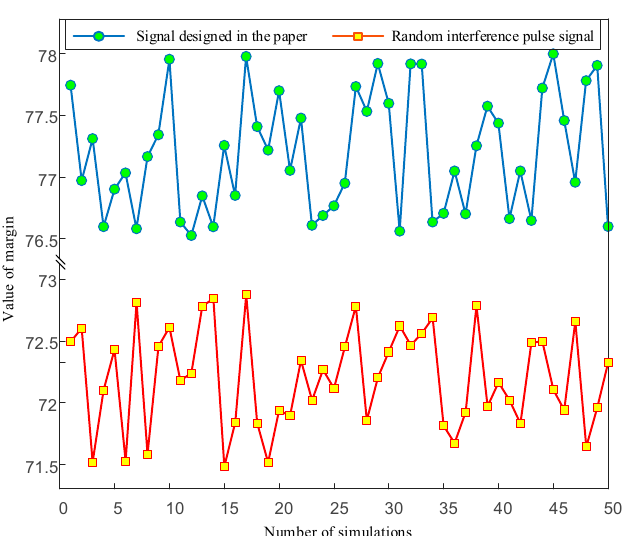
Figure 9. Line chart of signal margin value.